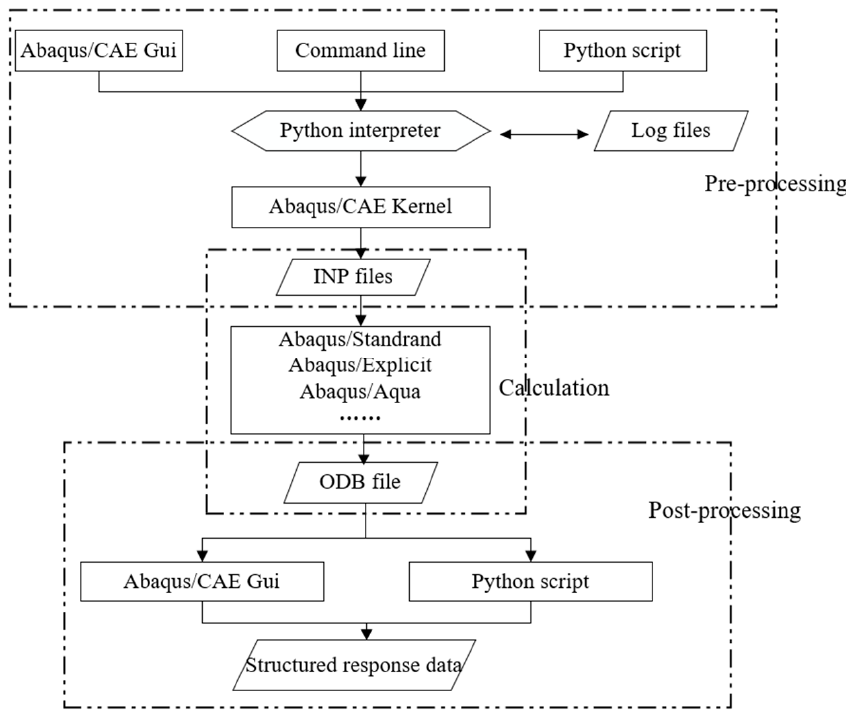
Figure 4. Schematic diagram of parametric modeling technology based on Abaqus and Python. The Python script for the SRM mainly contains six functions: geometric modeling, meshing, material definition, boundary setting, load setting, and result extraction. The content and order of the script are shown in Figure 5.